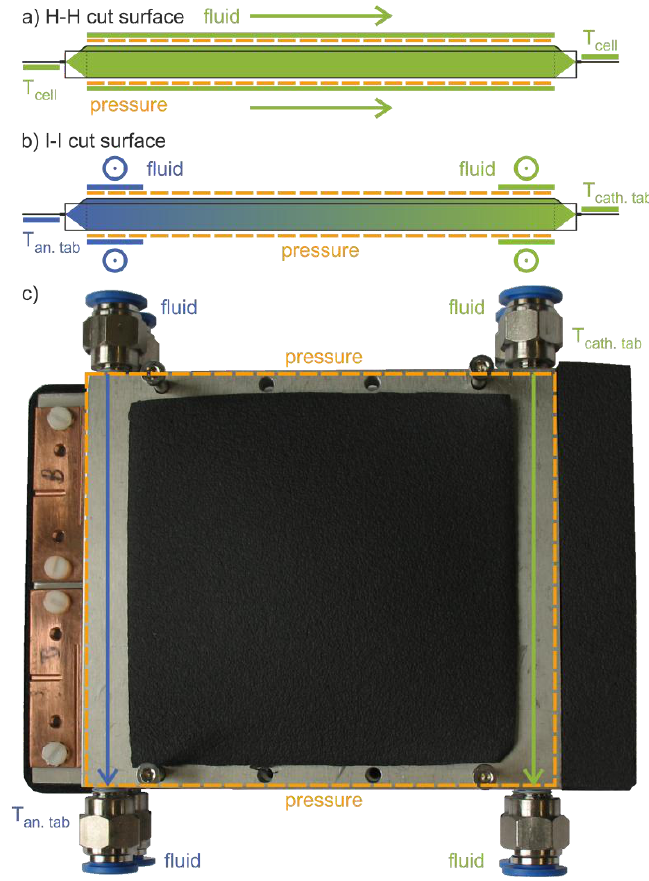
Figure 1. Schematic cross sections H-H and I-I of two types of cell holders (compare with Figure 2), each consisting of two plates with the cell in between. ( a ) Homogeneous temperature control T an.tab = T cath.tab due to the fluid flow along the cells and at both cell tabs. ( b ) Inhomogeneous temperature control via fluid cross-flow at both opposing cell tabs and the corresponding edges of the electrode stack with constant T cath.tab and T an.tab ≠ T cath.tab or T an.tab as a function of time. ( c ) Top view of the cell holder construction for two cells next to each other as part of the inhomogeneous setups.